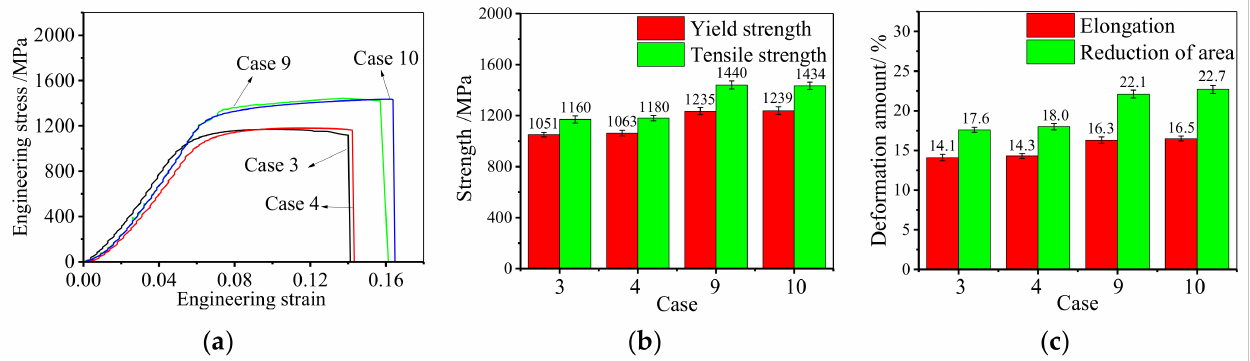
Figure 7. Comparisons of tensile mechanical properties at room-temperature and high-temperature: ( a ) engineering stress–engineering strain curve; ( b ) strength; ( c ) elongation to